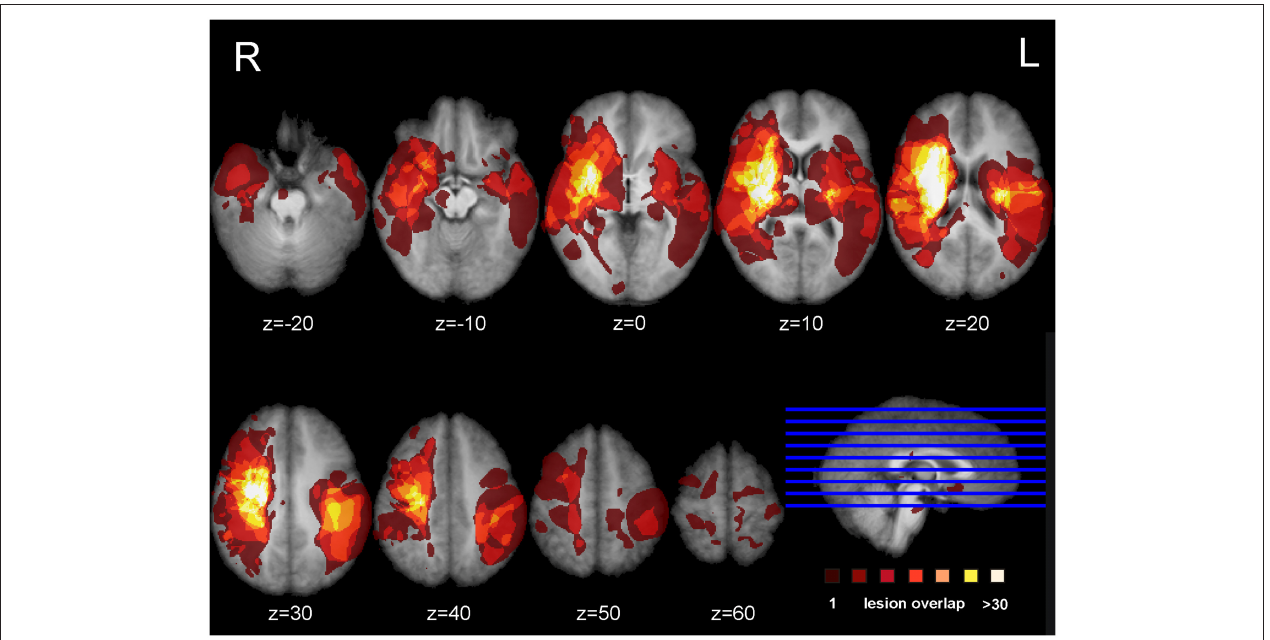
FIGURE 1 | Lesion overlap map. Overlap of the binarized lesions of the 37 stroke patients included in the study. Lesions are displayed over horizontal sections parallel to the AC-PC line. Brighter regions indicate a greater degree of overlap of